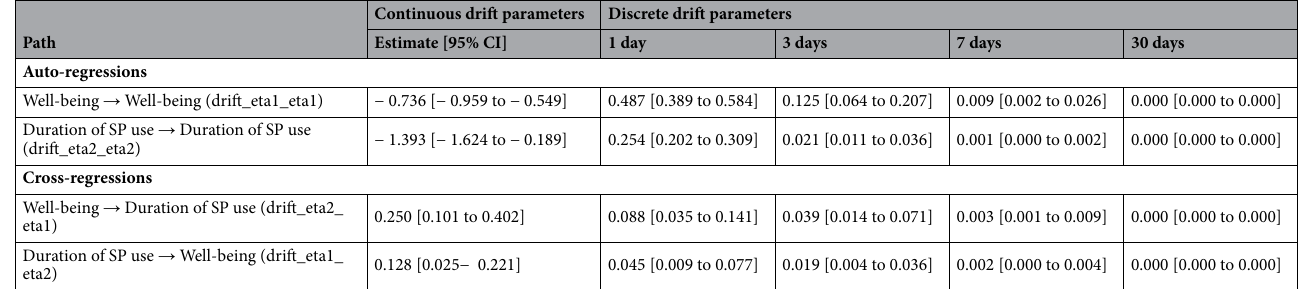
Table 2. Continuous and discrete parameter estimates of well-being and duration of smartphone use. SP smartphone. All effects not including the value of zero in the 95% CI interval were significant at the 0.05 level. Continuous drift parameters include continuous (i.e., time-independent) autoregressive and cross-lagged estimates in the drift matrix, Discrete drift parameters report the discrete (i.e., time-dependent) standardized effects at intervals of 1 day, 3 days, 7 days, and 30